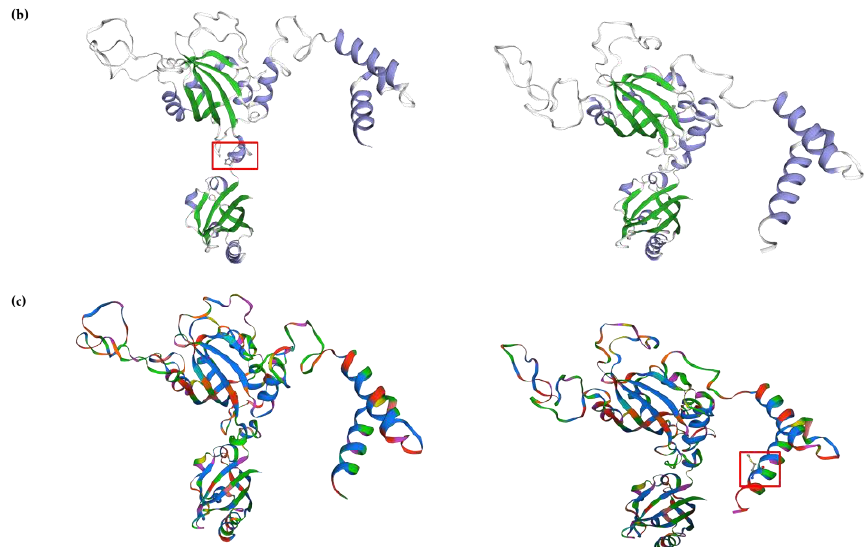
Figure 6. ARNT tertiary structure prediction and analysis: ( a ) ARNT tertiary structure in Hu and Texel sheep; ( b ) β -fold and α -helix of ARNT protein. The green peptide is β -fold, the purple peptide is α -helix, the red box shows one more α -helix in the Hu sheep than Texel sheep. ( c ) ARNT protein clustal of the Hu and Texel sheep. The red box shows one more protein clustal in the Hu sheep than Texel sheep.